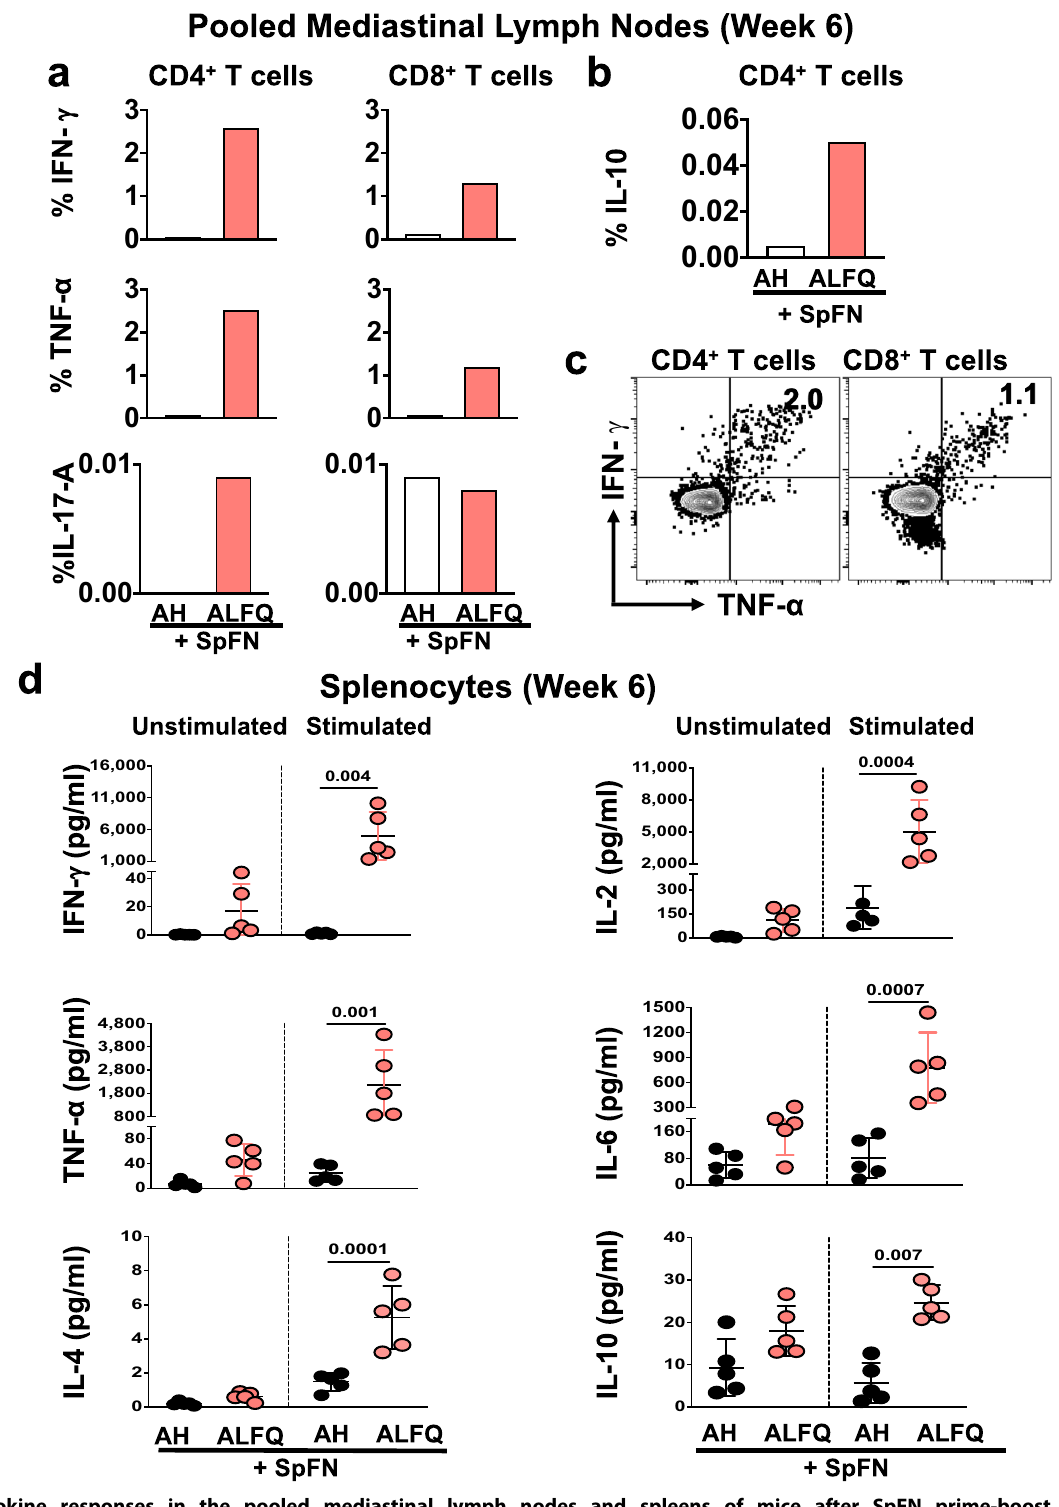
Fig. 4 Cytokine responses in the pooled mediastinal lymph nodes and spleens of mice after SpFN prime-boost vaccination. a , b Percentage of SARS-CoV-2 spike-speci fi c T cells in the mediastinal lymph nodes at week 6 (3 weeks post-prime-boost vaccination). a Percentage of CD4 + and CD8 + T cells expressing IFN- γ , TNF- α , IL-17A, and b CD4 + T cells expressing IL-10. Each sample is representative of the pooled lymph nodes within the vaccine group. c SARS-CoV-2 spike-speci fi c CD4 + and CD8 + T cells in the mediastinal lymph nodes following prime-boost vaccination with SpFN + ALFQ co-express IFN- γ and TNF- α upon peptide stimulation. d Splenocytes were stimulated with SARS-CoV-2 spike-speci fi c peptides and cytokines in the culture supernatants were measured by the ECLIA-based multiplex MSD platform. Dots represent data from individual mice ( n = 5/group), horizontal lines represent mean and error bars represent s.d. Differences between the two groups were analyzed by using a nonparametric Mann – Whitney U -test with p ≤ 0.05 considered as statistically signi fi